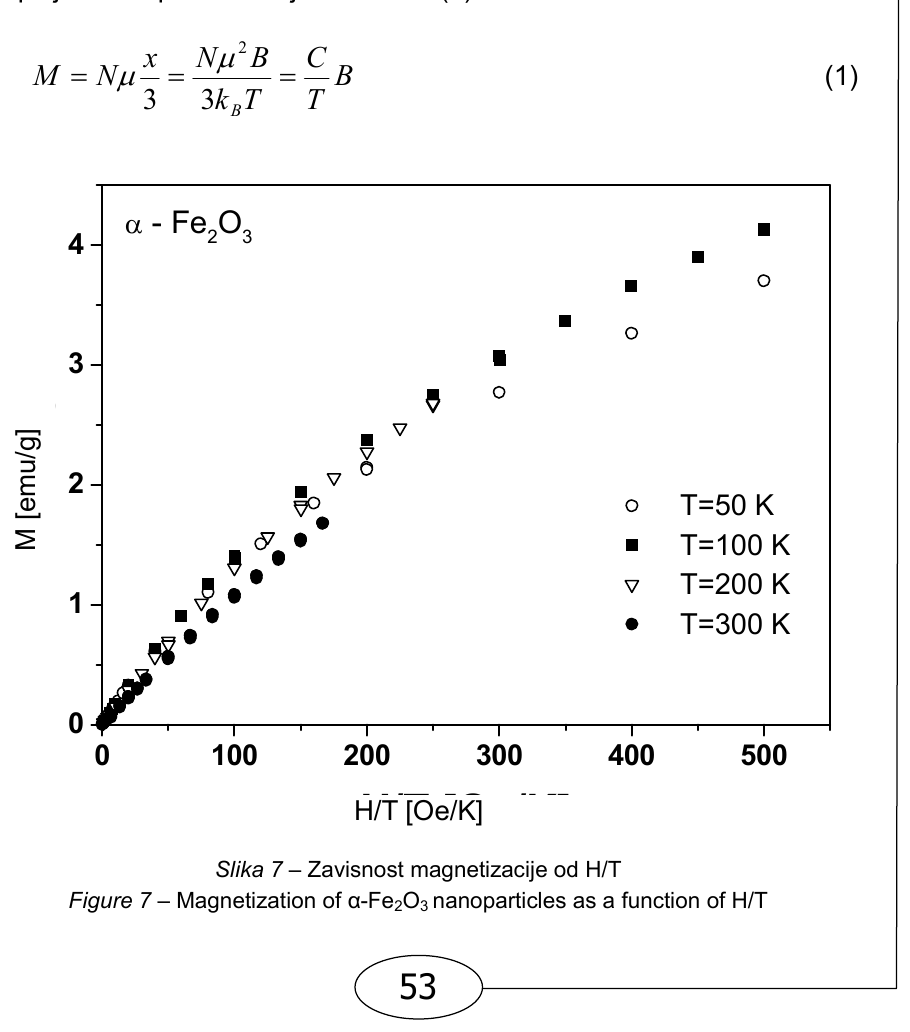
H/T Figure 7 – Magnetization of α -Fe 2 O 3 nanoparticles as a function of H/T